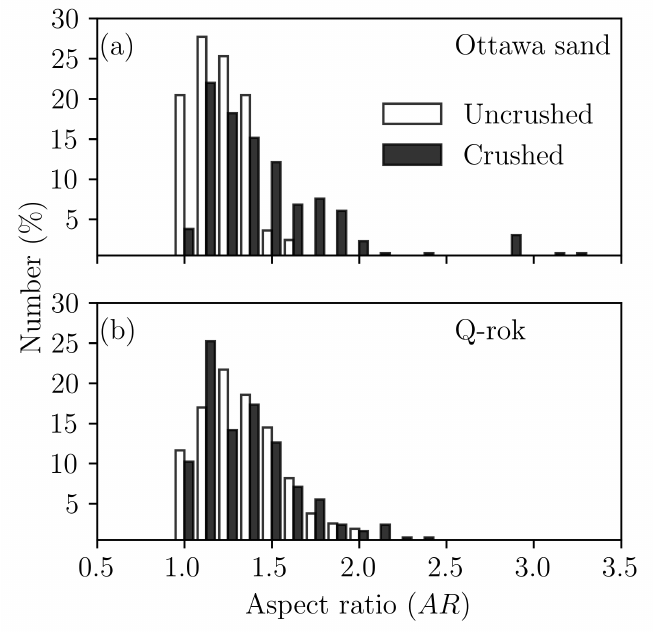
Figure 9. Particle shape evolution after 1D compression loading: ( a ) Ottawa sand, ( b ) Q-Rok.